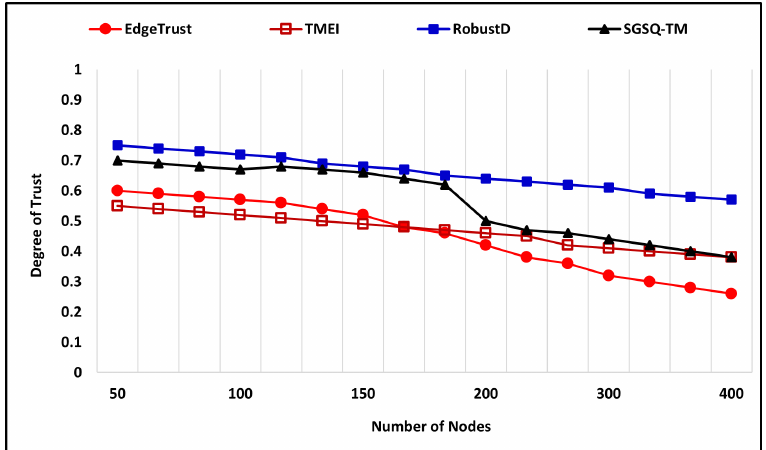
Figure 7. On-off attacks